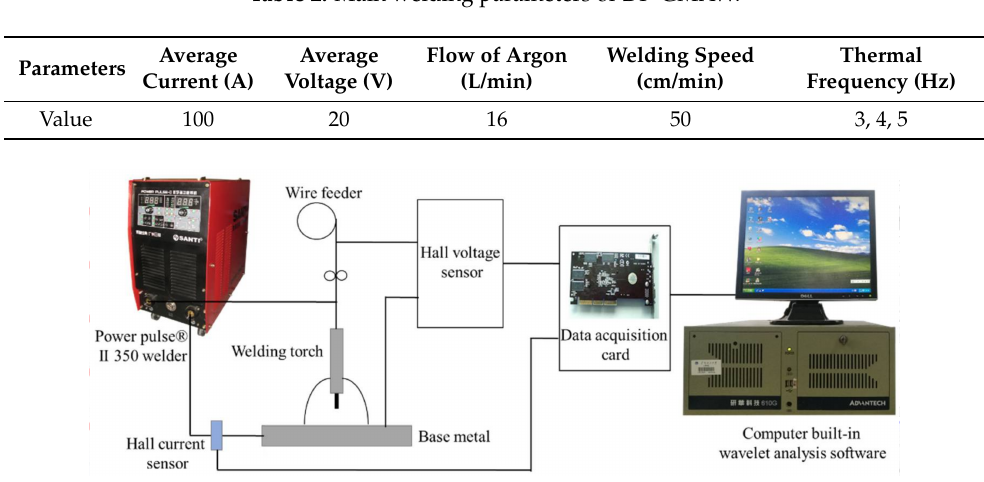
Table 2. Main welding parameters of DP-GMAW.